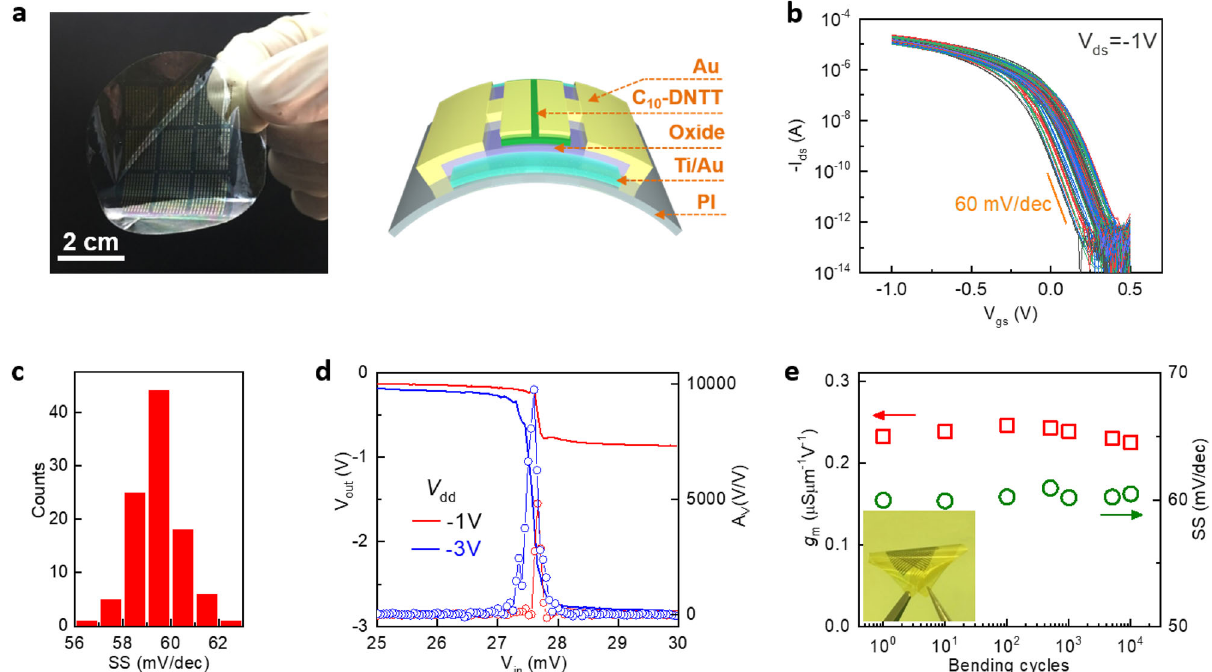
Fig. 4 Sub-thermionic OTFTs on fl exible substrates. a Photograph of OTFT arrays fabricated on 2-in. polyimide substrate (left) and schematic view of the device structure (right). b I ds − V gs curves of 100 devices under V ds = − 1 V. The L / W of device channel is 5 μ m/180 μ m. c Statistical distributions of SS for the devices in b . d Voltage transfer characteristics (solid lines) and A v (symbols) of an enhancement-depletion mode ampli fi er on fl exible substrate, under V dd = − 1 and − 3 V. e Bending test of a device on polyimide substrate. Both g m and SS remain stable during 10 4 bending cycles. Inset shows a photograph of fl exible device arrays under